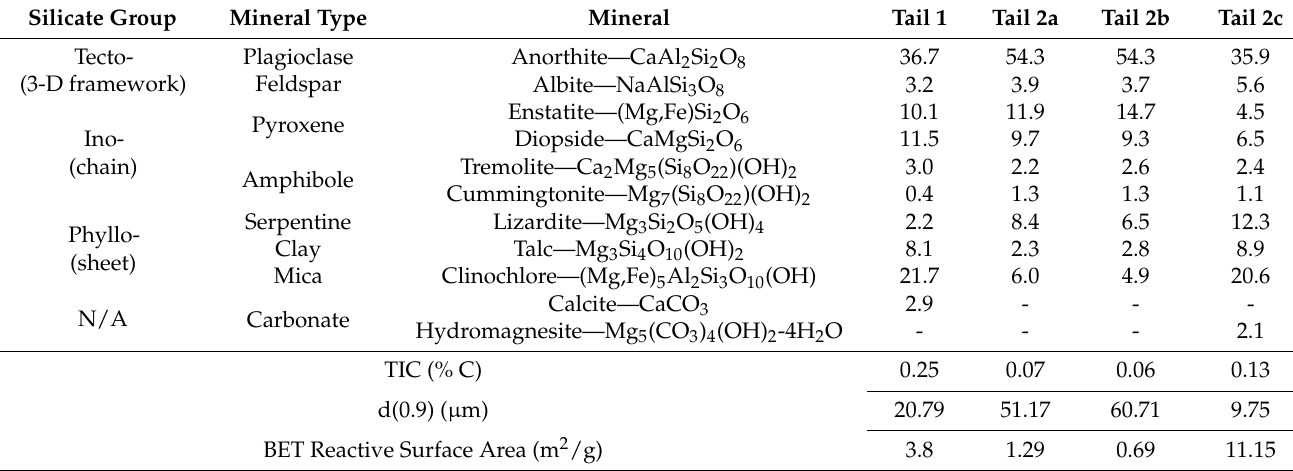
Table 1. Characteristics of Stillwater mine tailings: d(0.9) indicates that 90% of the sample analyzed is below the given particle size. Mineral abundances are given in weight